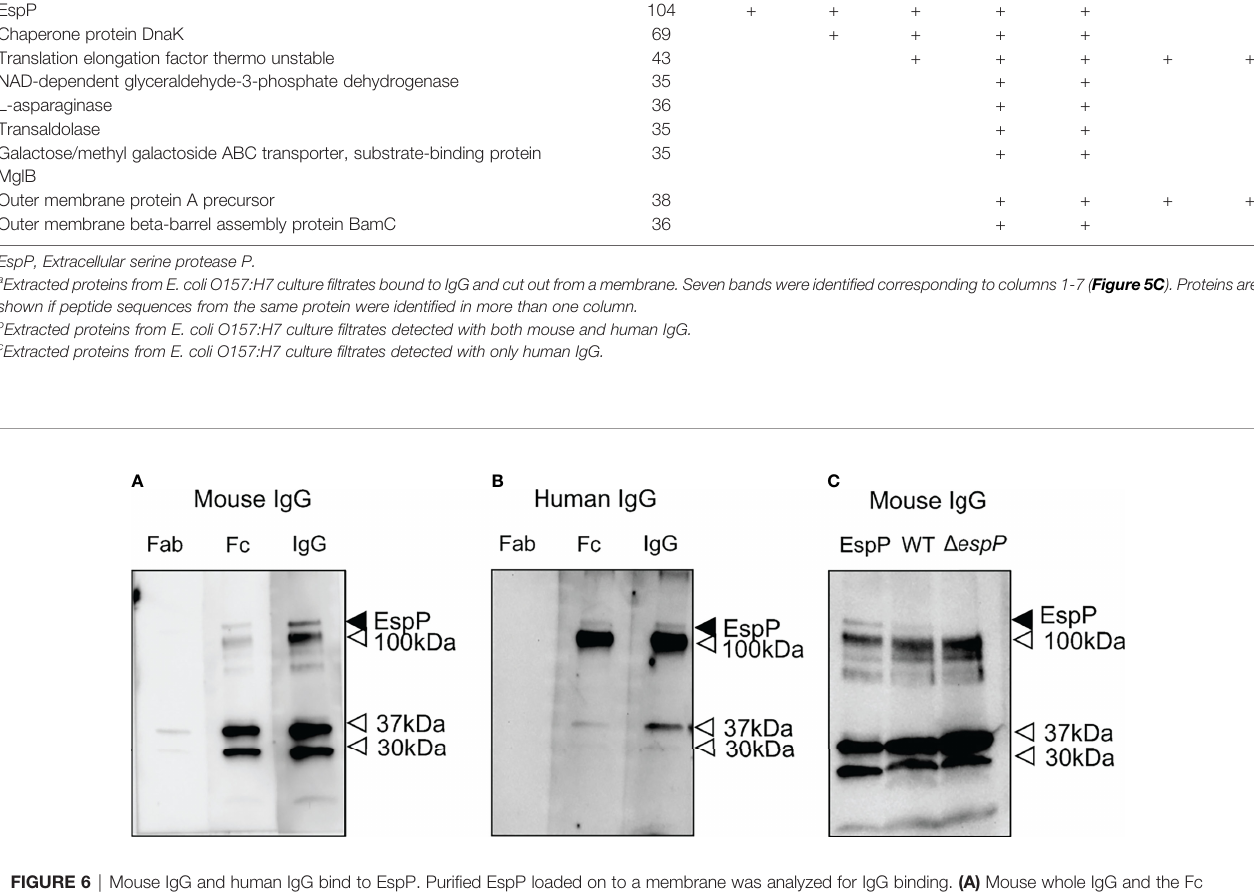
TABLE 2 | Proteins that bound IgG assayed by mass spectrometry. Extracted proteins a